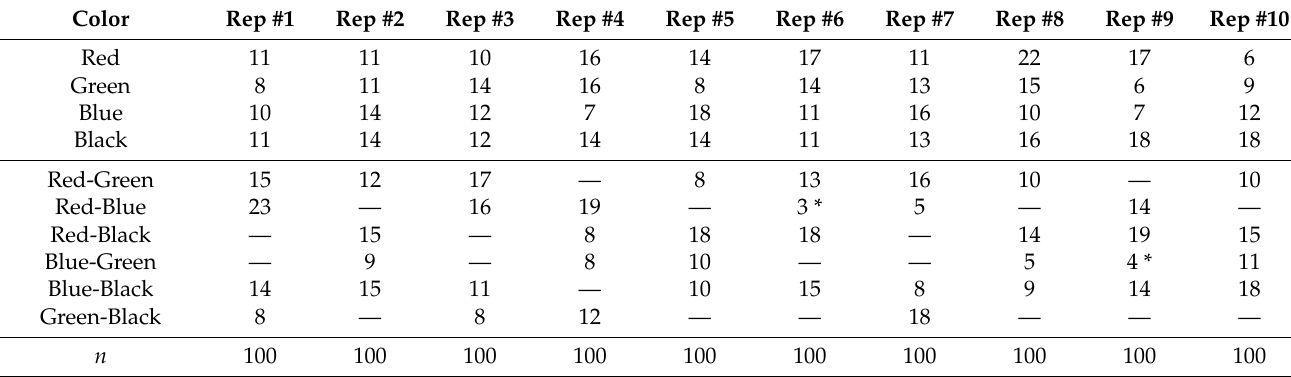
Table 4. Experiment #2. Movements of beetles to octants.